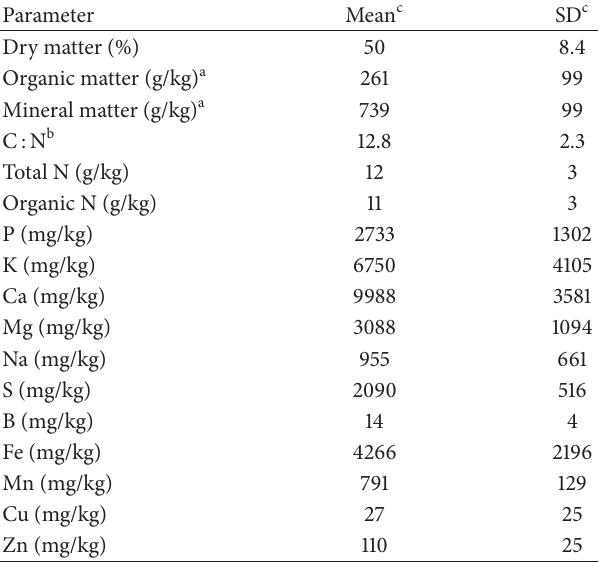
Table 2: Means and standard deviations for composition of composted cattle manure from the supplying farm in C´at Trinh Commune on a dry matter basis.